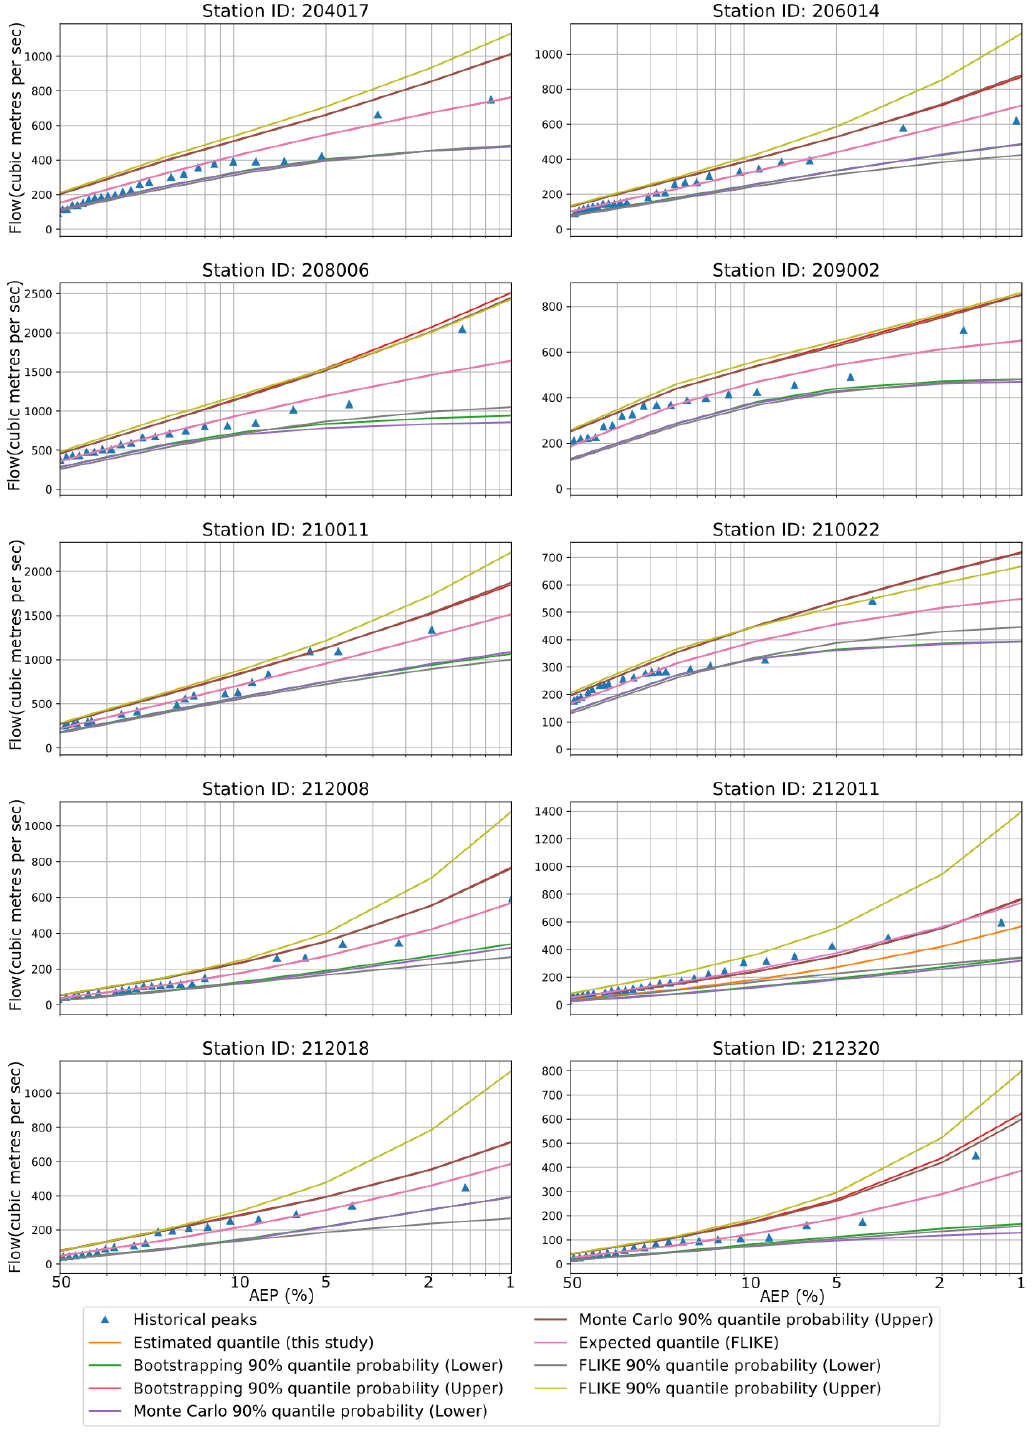
Figure 7. Flood quantiles from FLIKE and GPD distribution are presented over various AEPs for all 10 stations. CIs are estimated by FLIKE, BS, and MCST. The blue triangle symbolizes historical